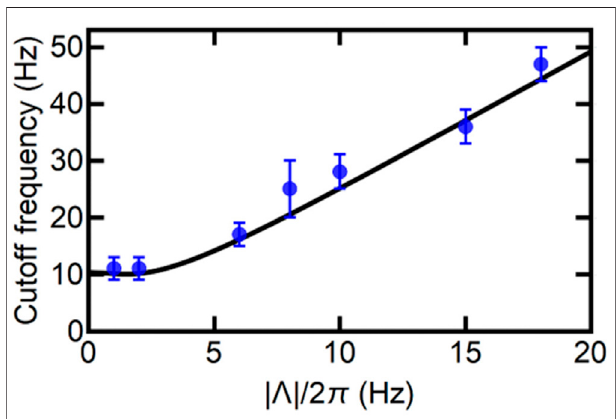
FIGURE 6 | The cutoff frequency as a function of optomechanical coupling strength magnitude | Λ |. The blue dots are the experimental measurementsandtheblackcurveisthetheoreticalsimulation.Theerrorbars are the standard deviations. Other experimental parameters are the same as in Figure 4